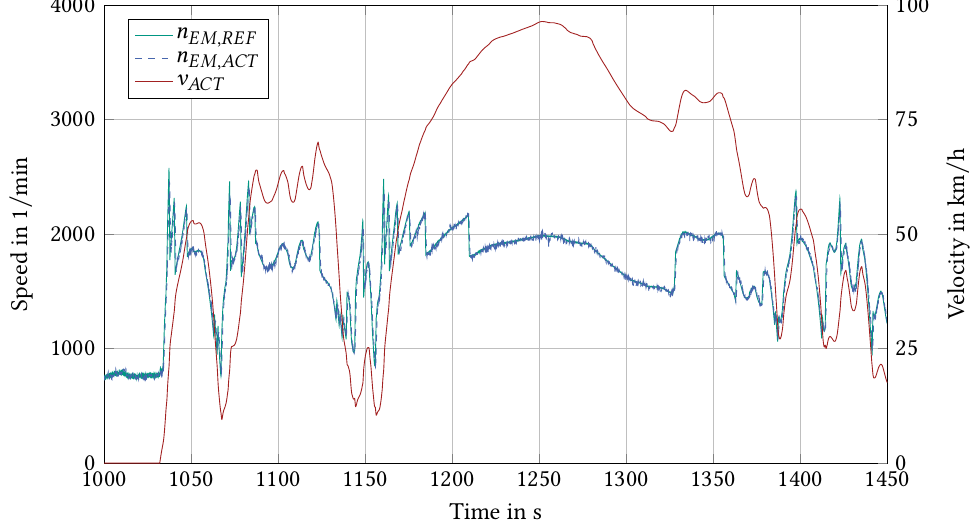
Figure 8. Reference n EM , REF and actual speed n EM , ACT of the EM in a WLTC compared to the virtual vehicle velocity v ACT